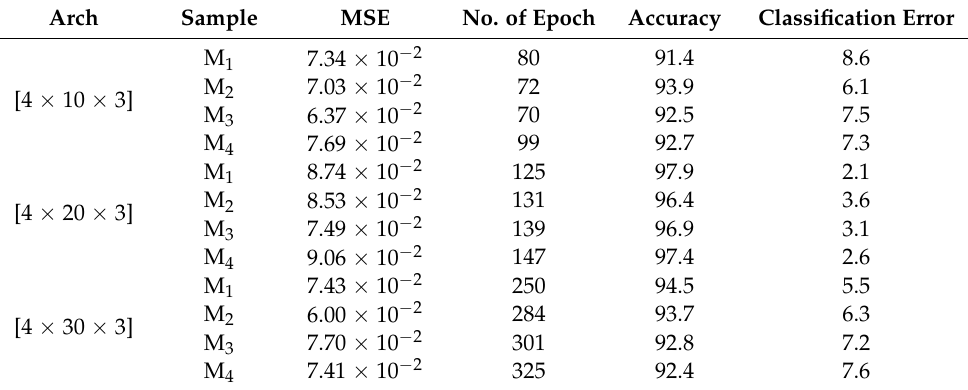
Table 4. Different ANN architecture for classification